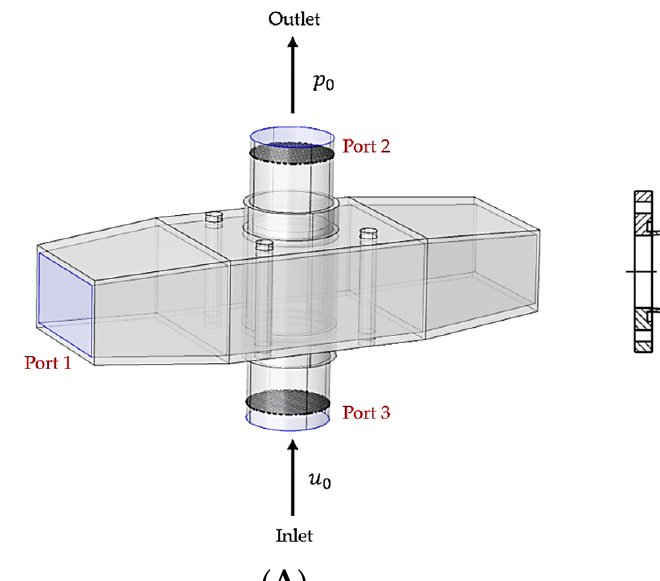
Table 2. Boundary conditions applied for the numerical calculations. Flow Boundary Conditions Interface